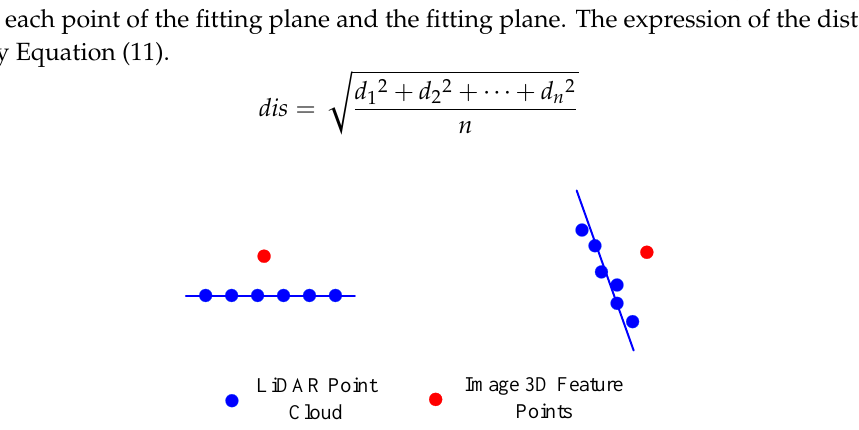
Figure 4. Di ff erent situations of three-dimentional (3D) feature Figure 4. Different situations of three-dimentional (3D) feature points.